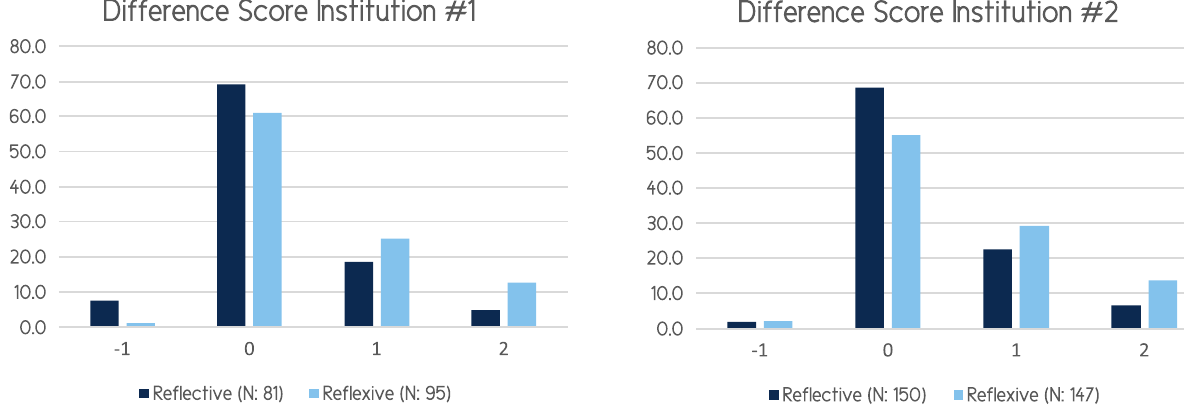
FIG. 5. Bar charts showing the percentage of students in each condition that achieved a specific difference